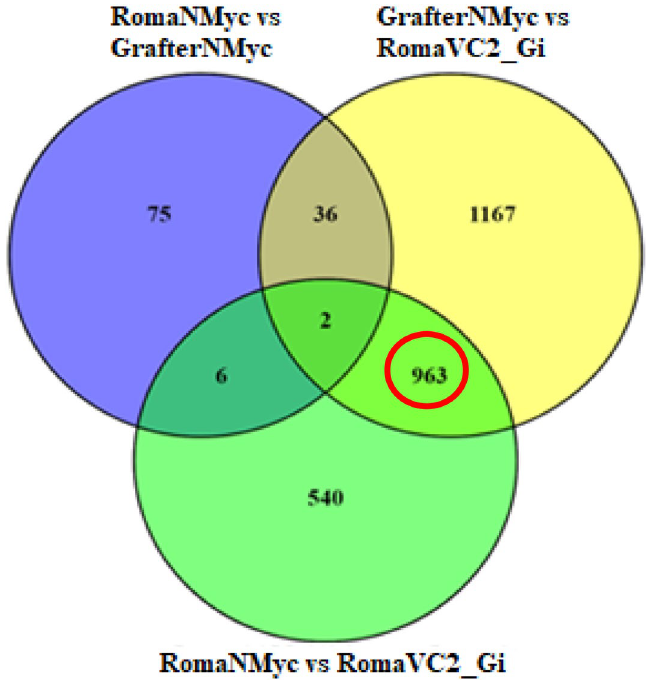
Figure 3. Comparison of the number of differentially expressed genes (DEGs) (up and down-regulated) for the non-inoculated host and non-host with AM-inoculated host. Venn diagram represents DEG profiles at FDR ≤ 0.05 and − 2 ≤ log fold change ≥ 2. Genes exclusively expressed in the basal root transcriptome (without any AM inoculation) is represented by the non-overlapping area of the blue circle (RomaNMyc vs GrafterNMyc). Yellow circle (excluding overlap area) represents DEGs in AM-inoculated host (RomaVC2_Gi) compared to non-inoculated non-host (GrafterNMyc). Non-overlapping region of green circle represents DEGs in AM-inoculated host (RomaVC2_Gi) compared to non-inoculated host (RomaNMyc). The 963 genes constituting the overlapping region (light green) in these two sets, are DEGs specific to AM-inoculation in hosts (up- and down-regulation) as these do not overlap with basal root profiles (blue circle). These genes were selected for further